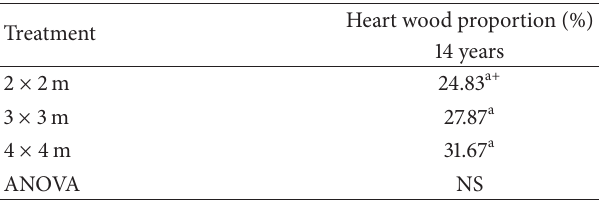
Table 4: Effect of spacing on heartwood proportion of T. grandis at